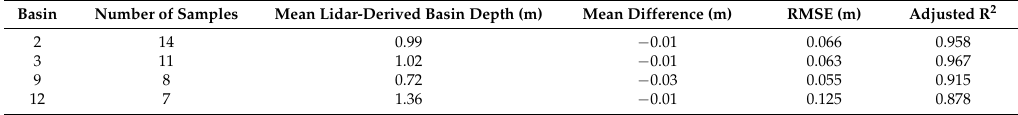
Table 4. Comparison of water-bottom measurements to Lidar-derived elevations ( d Z = h L − h g